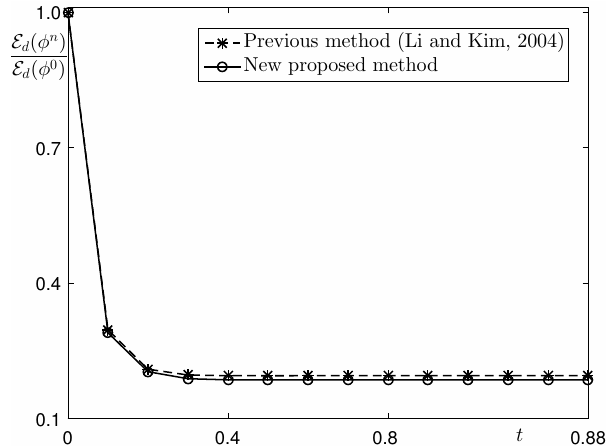
Figure 13. Time evolution of normalized total discrete energy for numerical solution by previous method [13] and new proposed method.